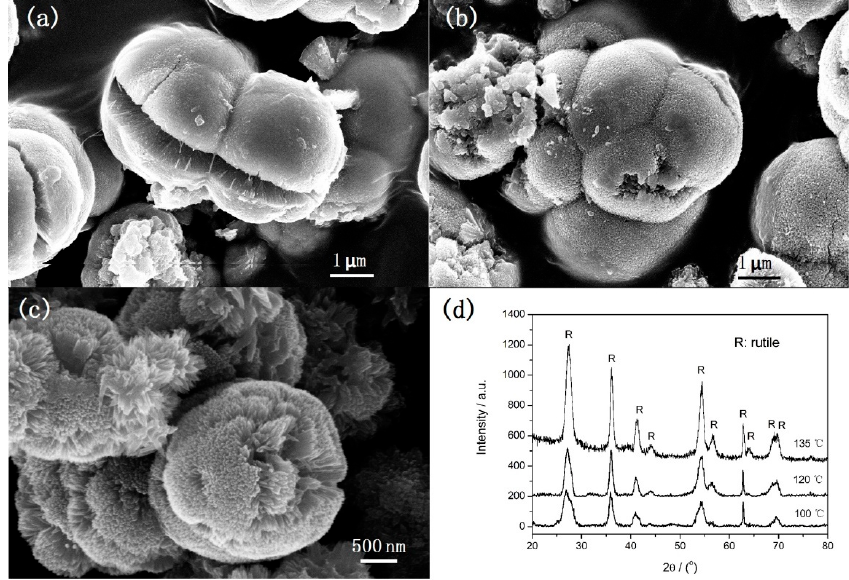
Figure 2. SEM images ( a – c ) and XRD ( d ) of TiO 2 synthesized at various temperatures under microwave irradiation for 5 min: ( a ) 100 °C; ( b ) 120 °C; ( c ) 135 °C.